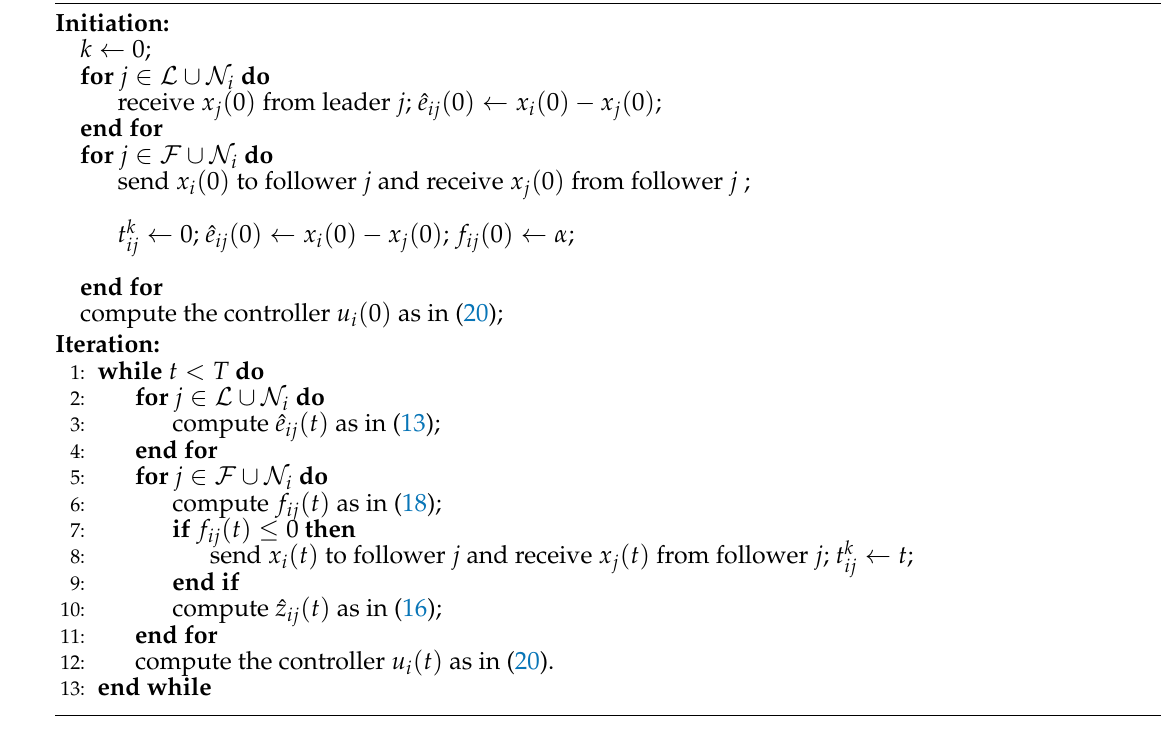
Algorithm 1 Event-Triggered Containment Control Algorithm for follower i: without input